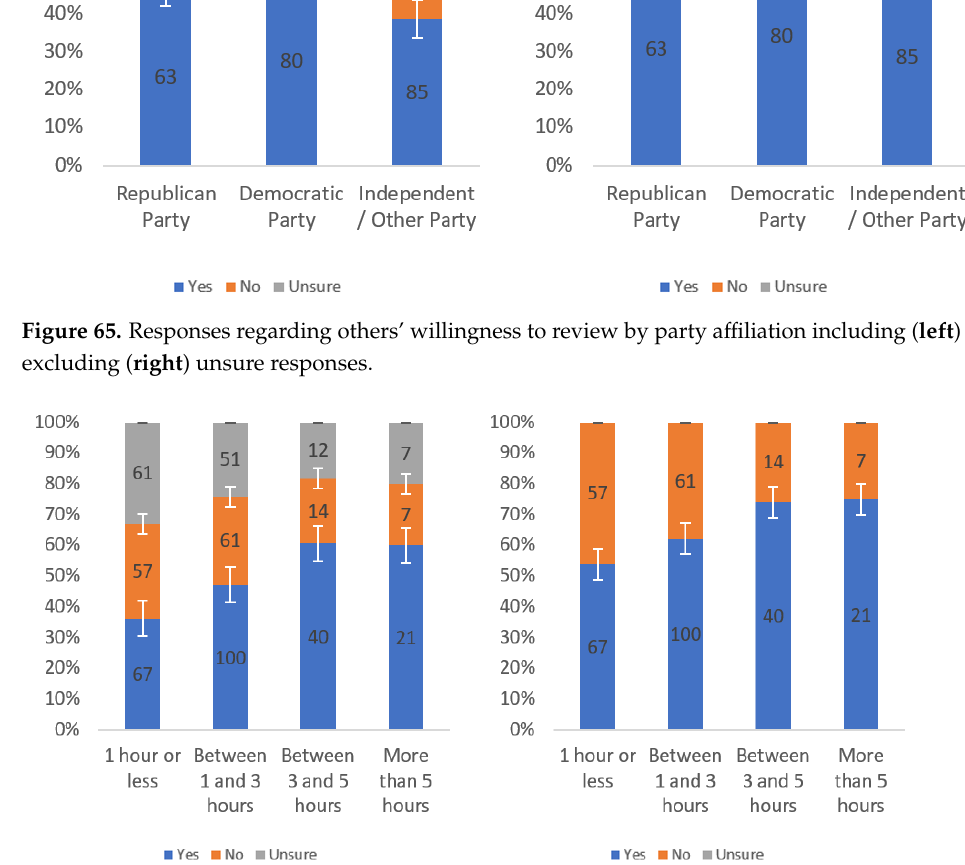
Figure 66. Responses regarding others’ willingness to review by internet usage level including ( left ) and excluding ( right ) unsure